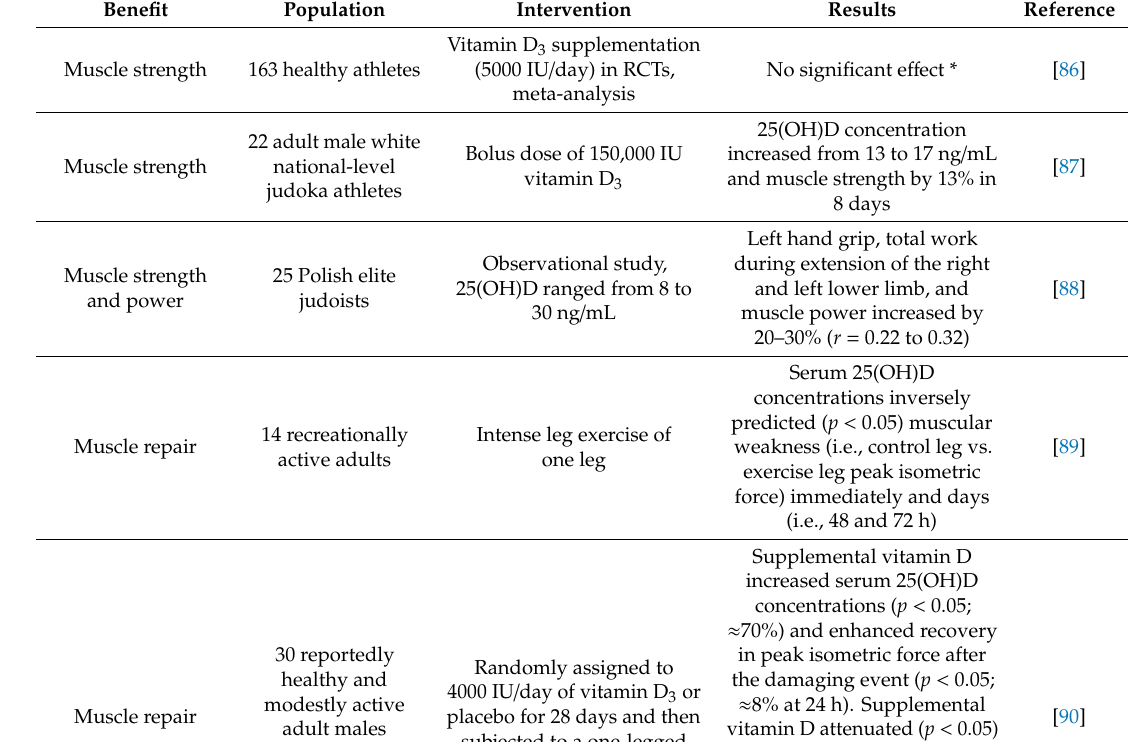
Table 1. Benefits of higher vitamin D status for